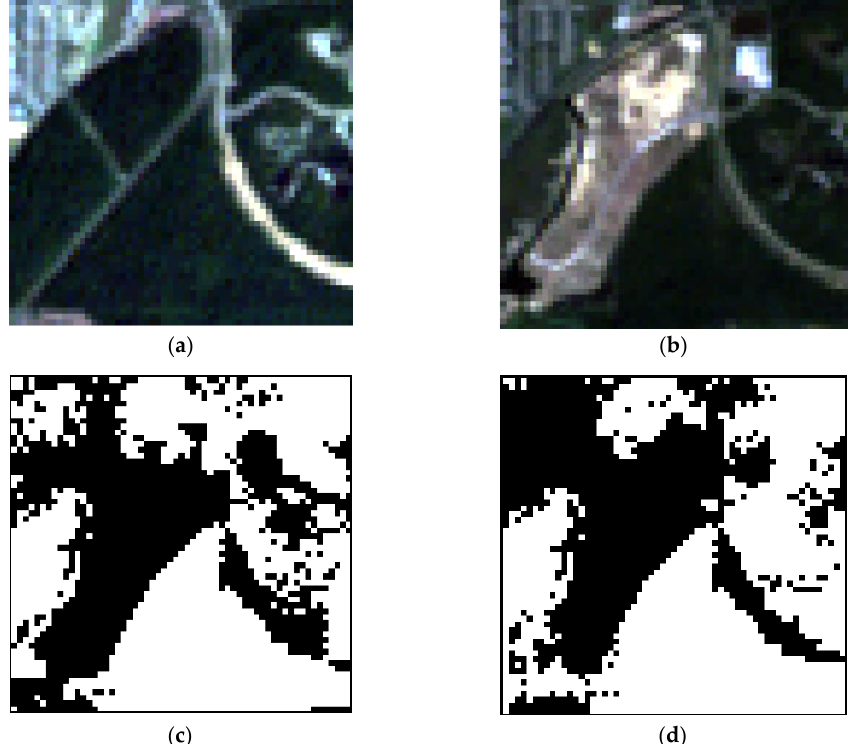
Figure 13. Comparison of the detection results for Landsat imagery: ( a ) original image in 2000; ( b ) original image in 2010; ( c ) without stacking analysis; ( d ) with stacking analysis